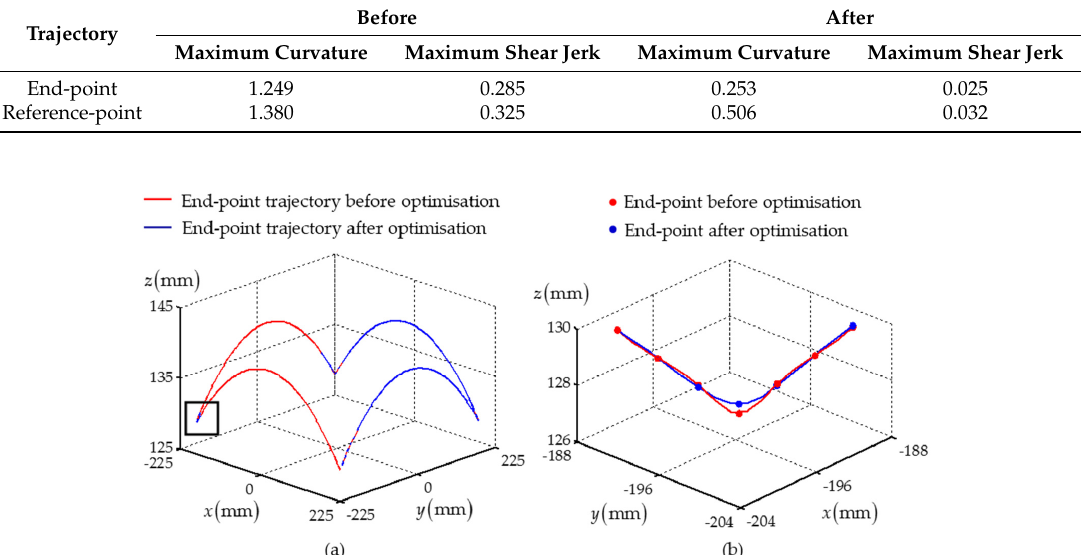
Figure 4. The end-point trajectory before, and after, fairing optimization: ( a ) the end-point trajectory; and ( b ) the partial enlarged view